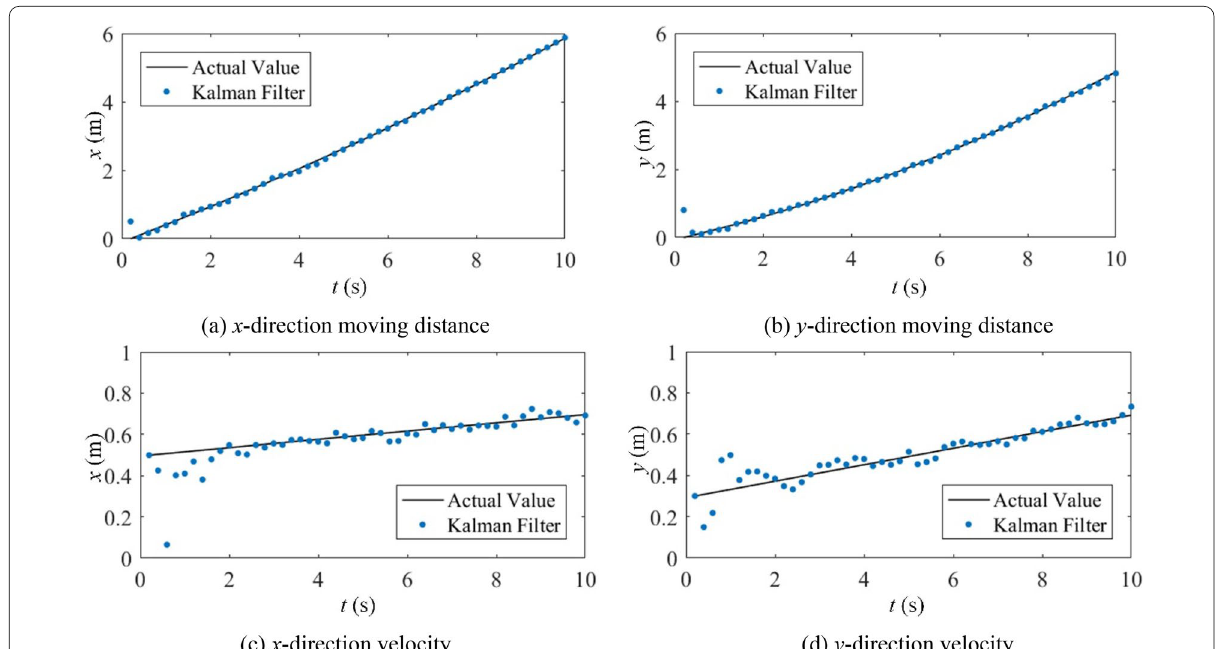
Figure 11 Simulation results of the Kalman